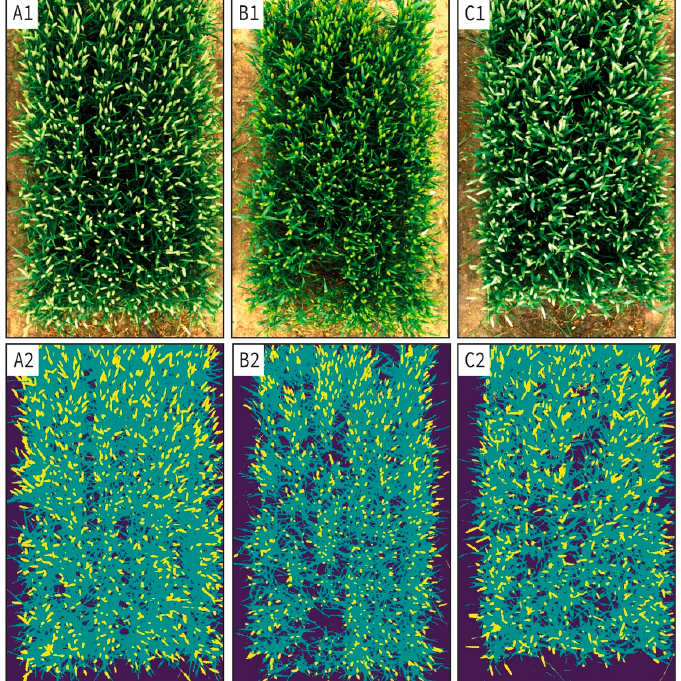
Figure 5. Classification maps; (A1, B1, C1) examples of digital images from wheat cultivar at the heading stage. The pseudo-RGB images (R:620 nm, G:535 nm, B:445 nm) are generated from the hyperspectral imaging; (A2, B2, C2) the classification map obtained by the proposed algorithm which separates sunlit-ear (SE) and sunlit-leaf (SL) pixels from the background (BG).